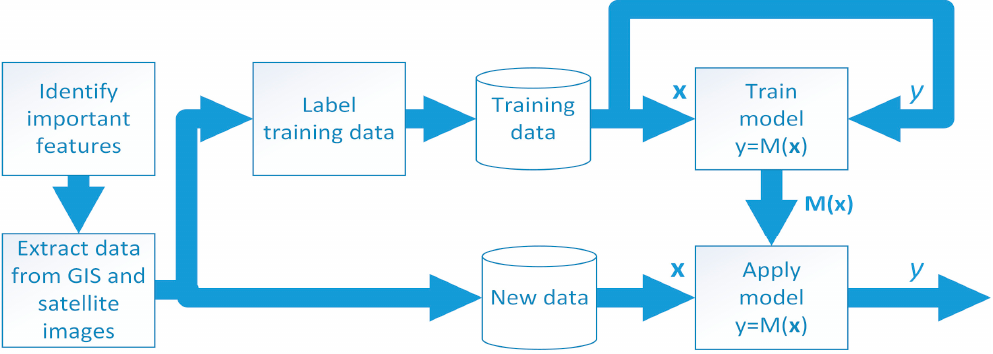
Figure 1. A scheme of the concept of machine learning algorithms applied to species distribution modelling.